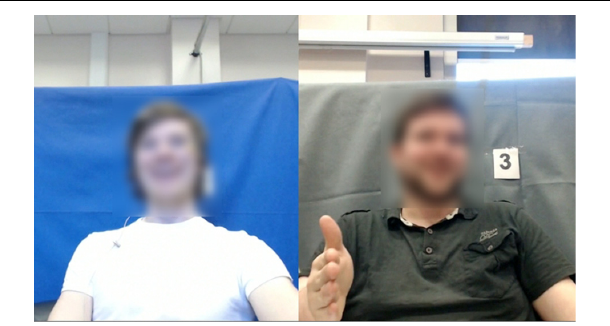
FIGURE 1 | Screenshot of the interaction stimuli. The story teller and listener were positioned on the right and left, respectively. Each interaction lasted approximately ten seconds, during which time the unfolding story led up to the laughter event. The listener’s audio–visual stream was frozen at a frame containing a neutral facial expression up until the point where the laugh response began. Faces were not blurred during the actual